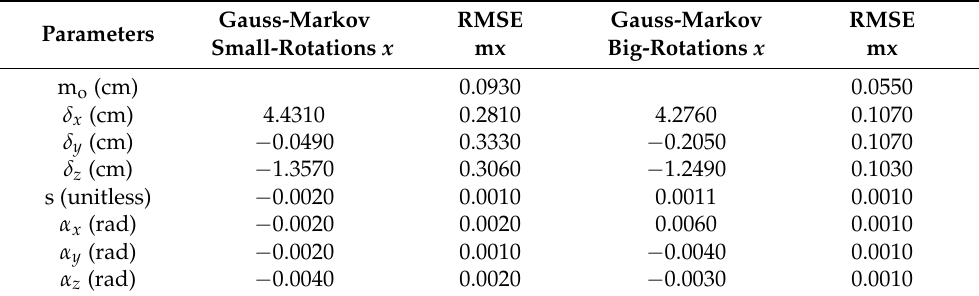
Table 3. Aristotle sculpture: transformation parameters ( x ) with their RMSE ( m x ) in coarse registra- tion with the new algorithm.